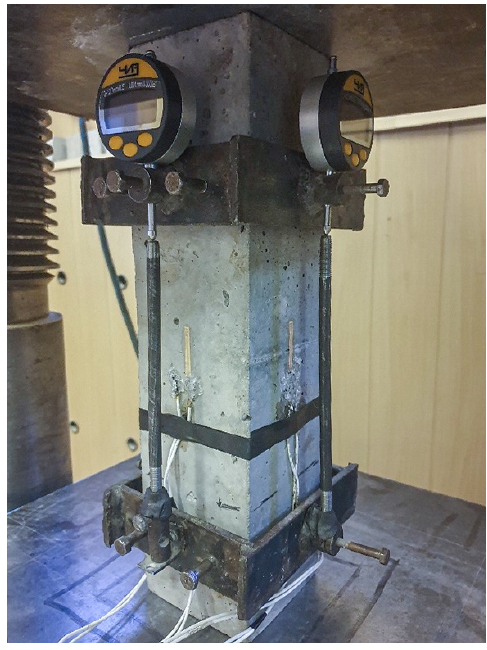
Figure 4. The process of measuring concrete deformations. with the requirements of GOST 10,180 “Concretes. Methods for strength determination using reference specimens”